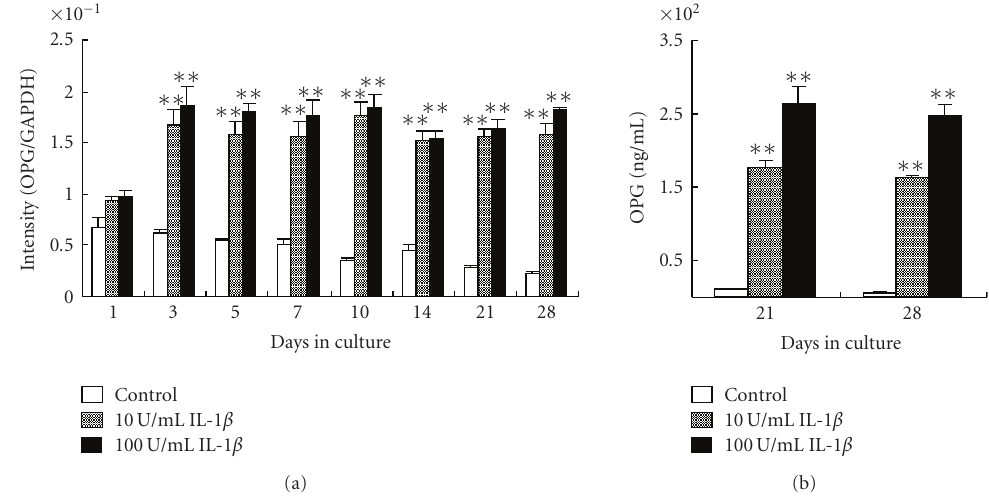
Figure 3: E ff ect of IL-1 β on OPG gene and protein expression. (a) Cells were cultured with 0, 10, or 100U/mL IL-1 β and OPG gene expression was determined by real-time PCR on days 1, 3, 5, 7, 10, 14, 21, and 28 of culture. (b) OPG protein expression determined by ELISA on days 21 and 28. Each bar indicates the mean ± SD from four separate experiments. ∗∗ P < . 01 for IL-1 β treatment versus the